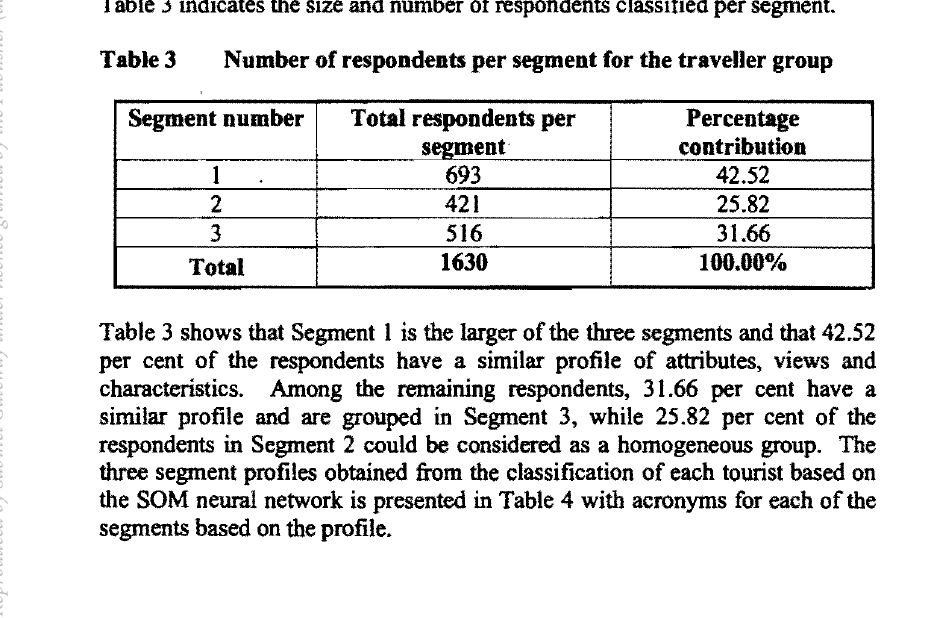
Figure I indicates four possible segments, three of which are defmitive, while the fourth is smaIler and appears to be developing. However, for the purposes of this analysis, the respondents that fonn part of the "emerging" market segment are included together with respondents classified as part of segment 3. Table 3 indicates the size and number of respondents classified per segment. Table 3 Number of respondents per segment for tbe traveller